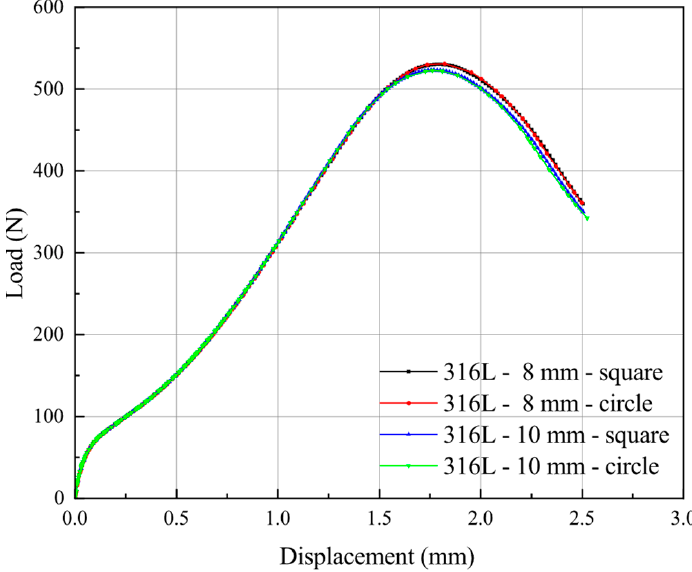
Figure 14. Force–displacement curve of SPT test for sp e cimens in Table 7.